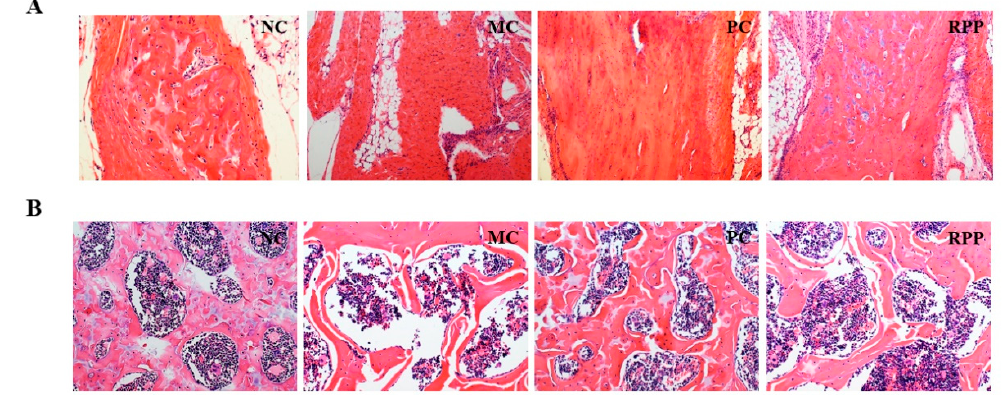
Figure 9. Hematoxylin and Eosin (H&E) staining in right pelvic limb femurs of rats(magni fi cation 400×). The microarchitectures of the ( A ) cortical and ( B ) trabecular bones were detected.